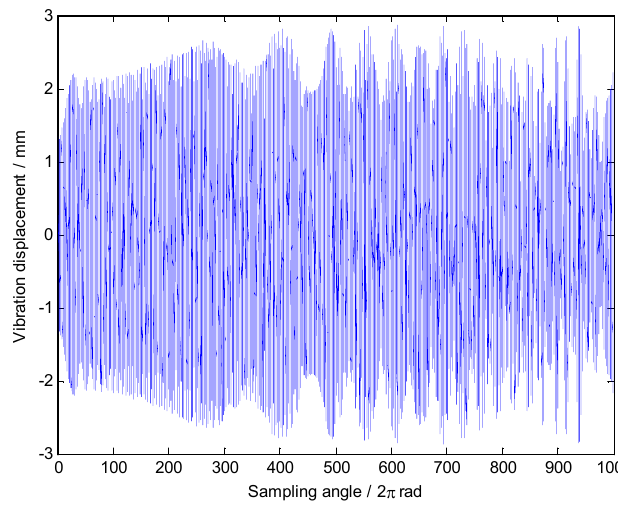
Figure 7. The angular-domain reconstruction signal under variable rotation speed (VRS).